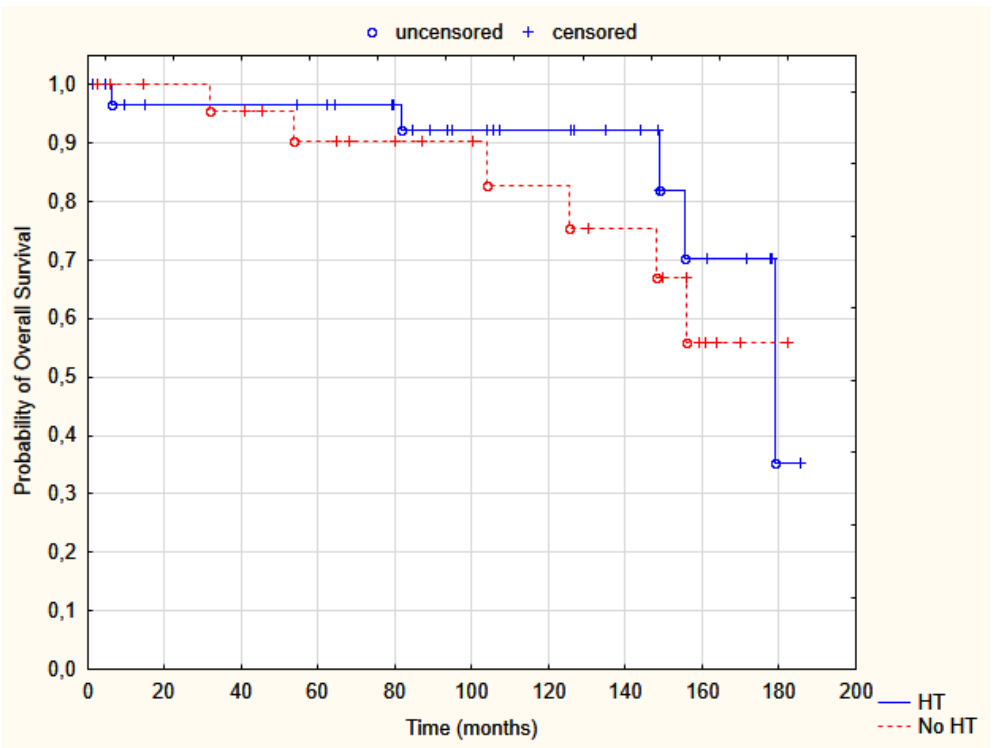
Figure 3. Probability of overall survival in group A, HDR-BT (red dotted line), and B, HDR-BT + thermal boost (solid blue line); Test log-rank, p = 0.46. HT—hyperthermia.